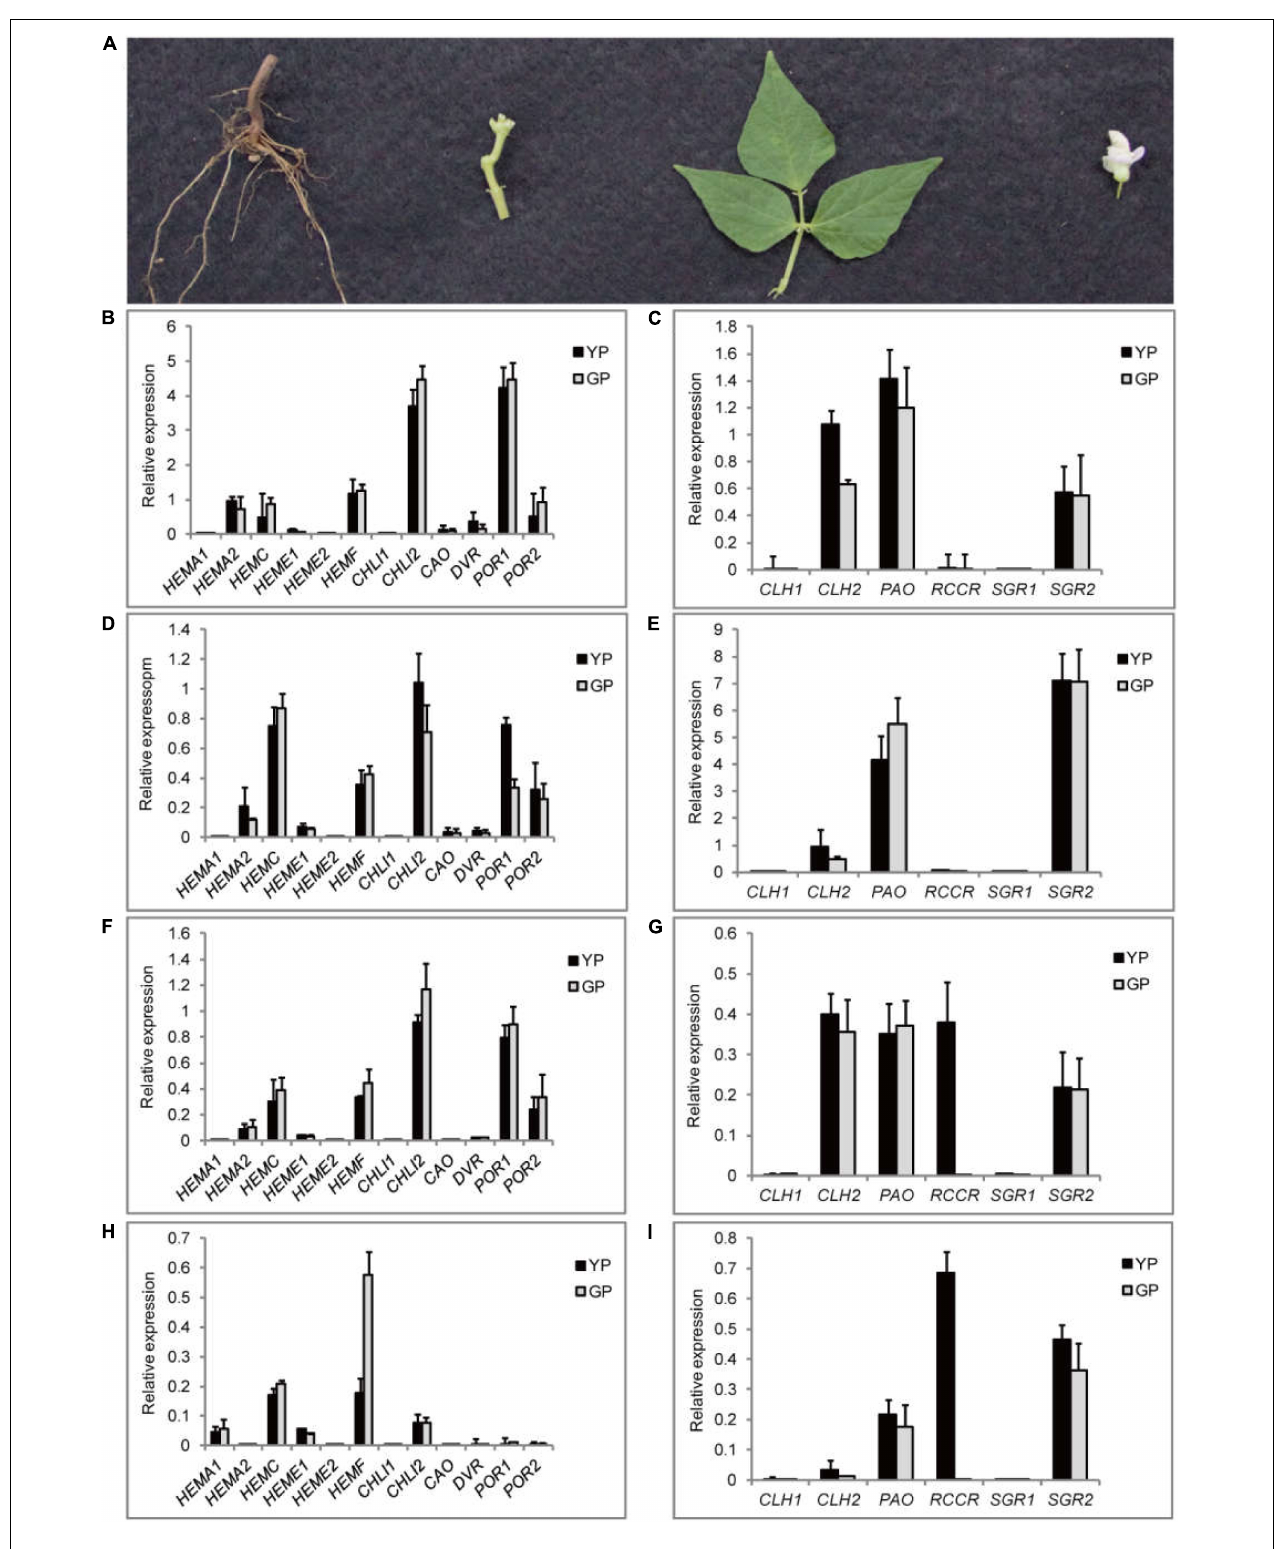
FIGURE 6 | Transcription levels of 18 DEGs involving in chlorophyll synthesis and degradation pathway in different tissues. (A) The pictures of different organs of common bean. (B–I) The relative transcript levels of chlorophyll synthesis and degradation, respectively, in four different organs: (B,C) leaf, (D,E) flower, (F,G) stem, and (H,I)